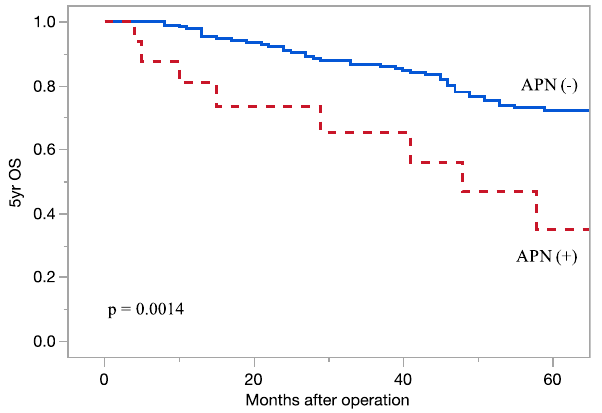
Figure 1. Kaplan–Meier curves showing the 5-year OS rates of high-risk stage III patients with and without APN metastasis. Outcomes of patients with high-risk stage III colorectal cancer. The 5-year OS rates of patients with and without APN metastasis were 35.0% and 72.1%, respectively (p = 0.0014). OS: overall survival, APN: apical lymph node.